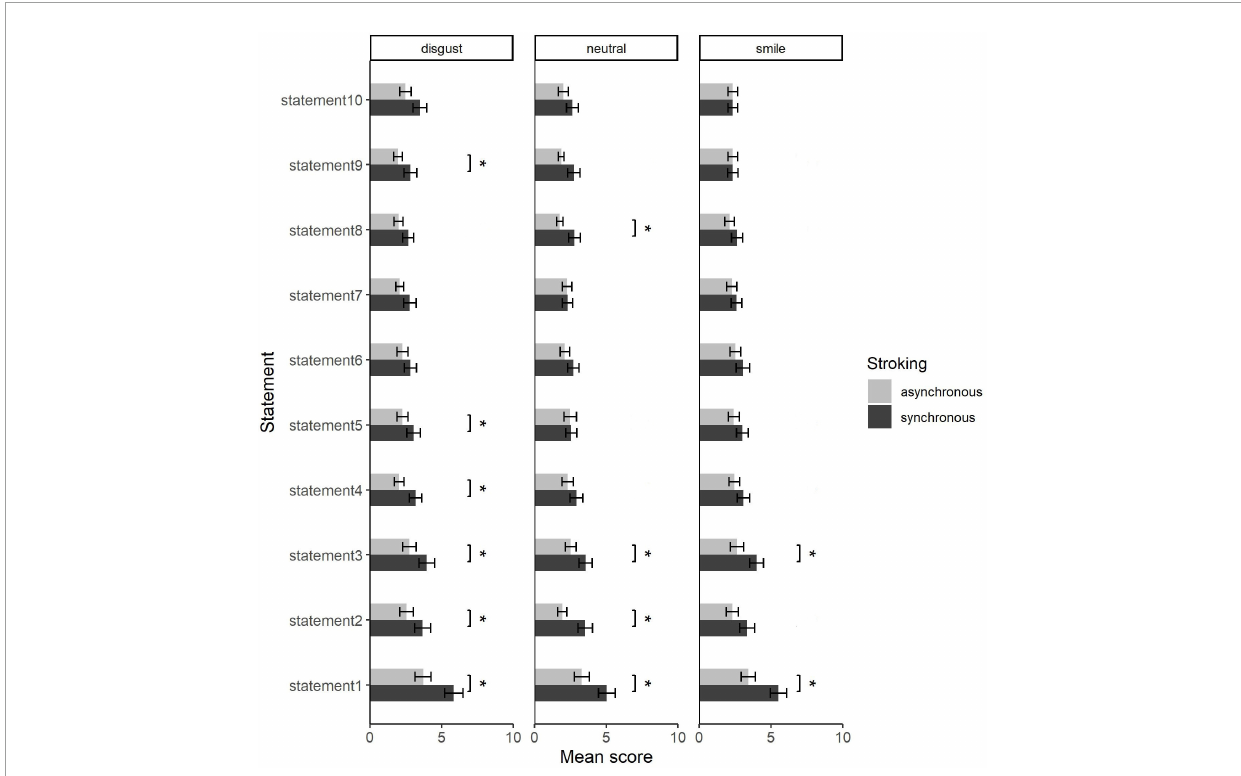
FIGURE4 Rating scores of each statement for each condition averaged across participants. Error bars show standard errors of mean. * p < 0.05 with controlled false discovery